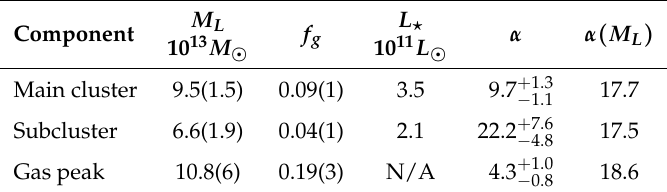
Table 2. Lensing mass, gas fraction, stellar luminosity and the MOG α parameter (estimated assuming a stellar mass-to-light ratio of Υ (cid:63) = 1) and the same parameter computed from M L for components of the Bullet Cluster. Using data from [2] and [26] (for the main gas